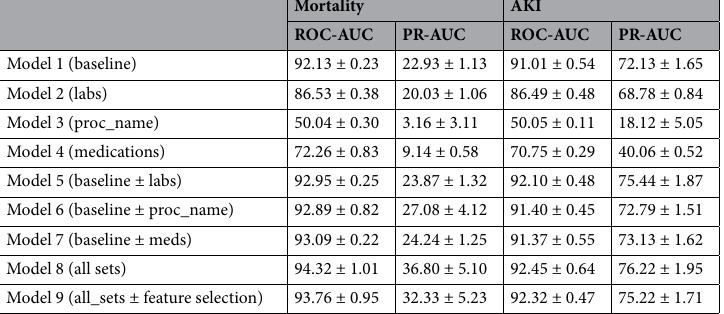
Table 2. Performance metrics for XGBoost model. XGBoost model performance metrics for predicting in-hospital mortality using different sets of features.